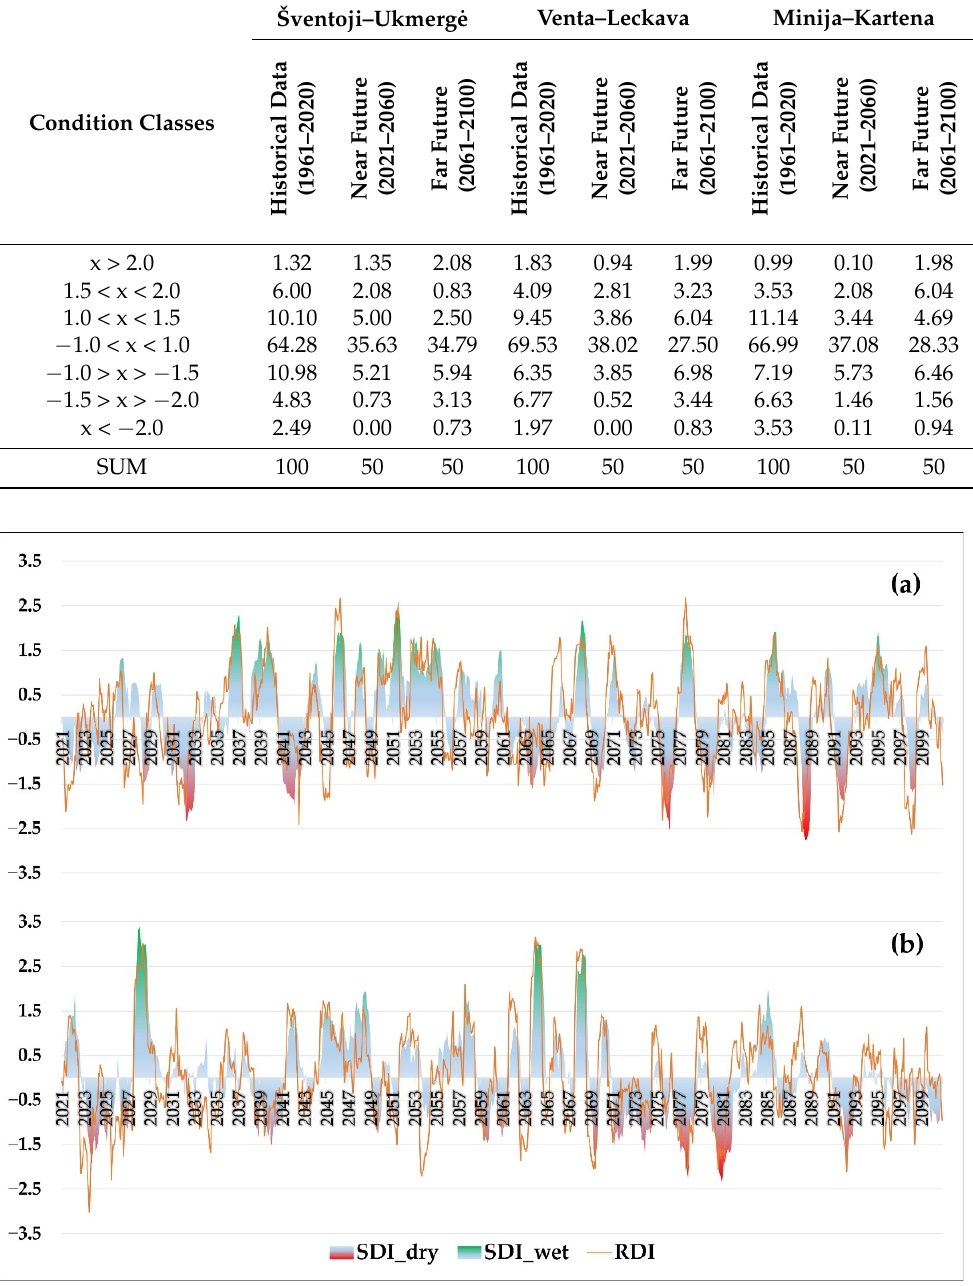
Figure 13. The Šventoji River, accumulation period 12 months: ( a ) RCP 4.5; ( b ) RCP 8.5. The Venta is characterized by similar amplitudes of the hydrological index values of both climate scenarios (Figure 14). According to both climate scenarios, the number of hydrological droughts and the amplitude of the values will increase in the far future. As in the Šventoji, there will be more extreme droughts under the RCP 4.5 scenario.